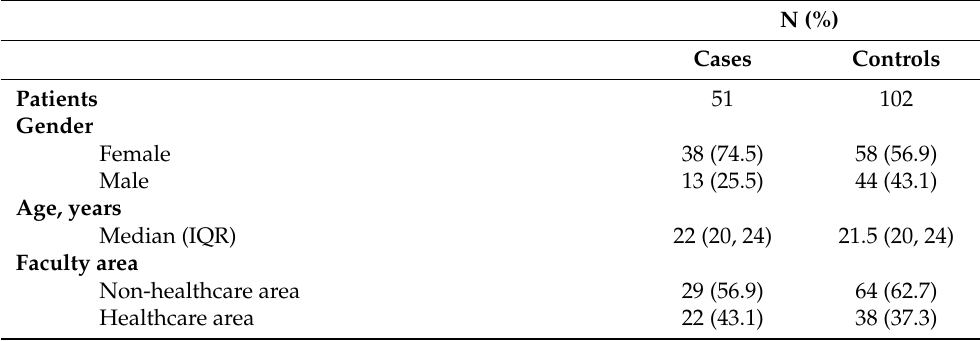
Table 1. General characteristics and contacts of SARS-CoV-2 among case and matched control students attending the Sapienza University of Rome between October 2020 and July 2021. Results are expressed as frequency (percentage) of the median (interquartile range).